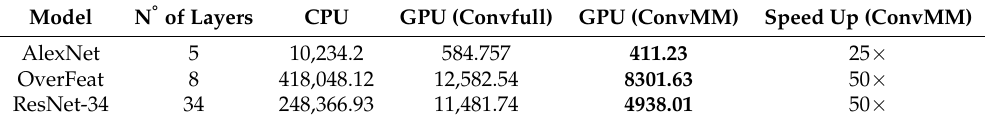
Table 6. Classification time of deep models (ms), best results are written in